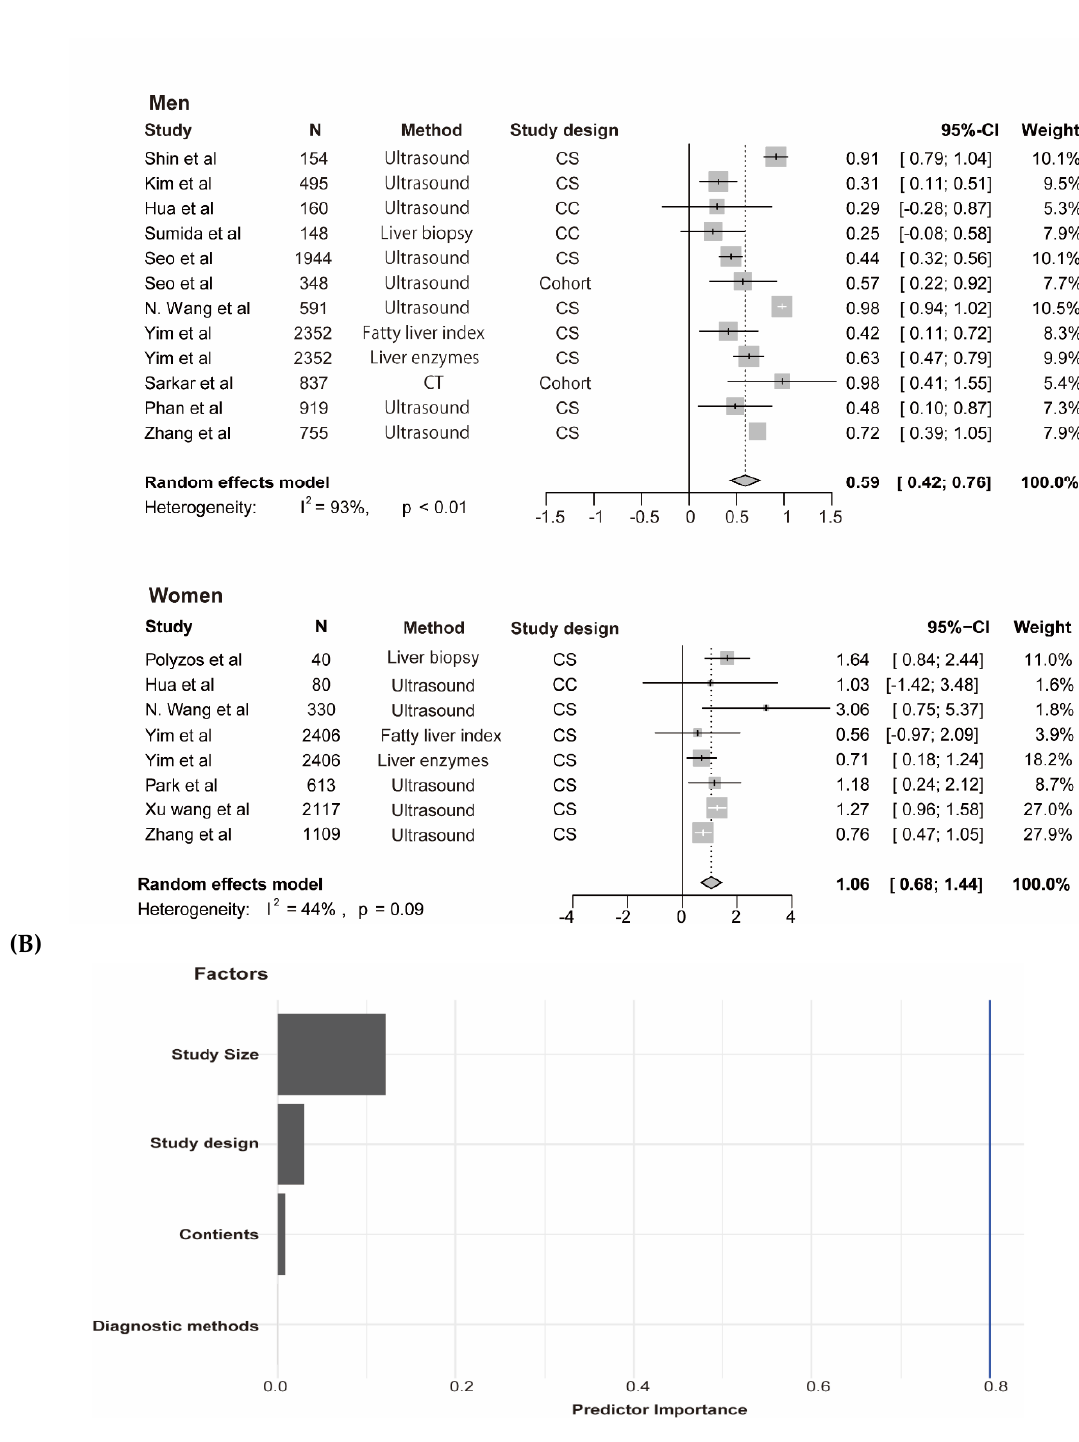
Figure 4. Association of SHBG with NAFLD. The summary estimate (center of diamond) and 95% confidence interval (width of diamond) were synthesized by using a random effect model which is shown in bold. Abbreviations: NAFLD, non-alcoholic fatty liver disease; SHBG, sex hormone-bind- ing globulin.